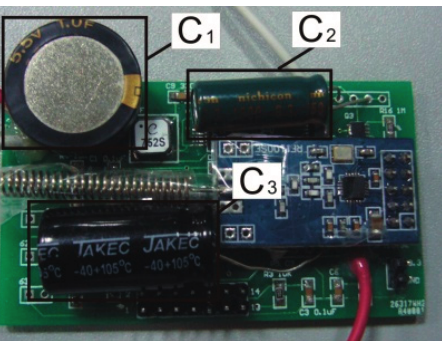
Figure 9. Photo of power management